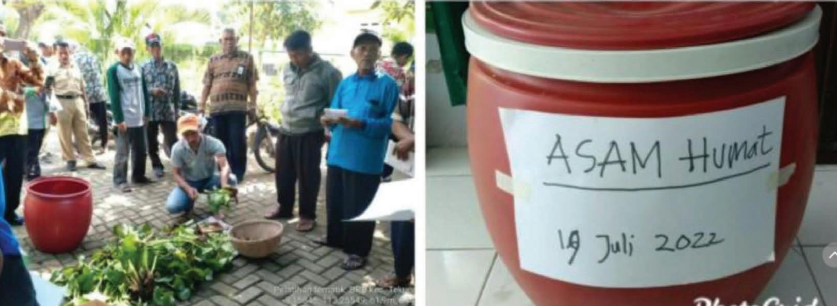
Figure 7: Training on making humic acid with water hyacinth ( Eichhornia crassipes ) as raw material for farmer groups in East Java, Indonesia (source: Imelda